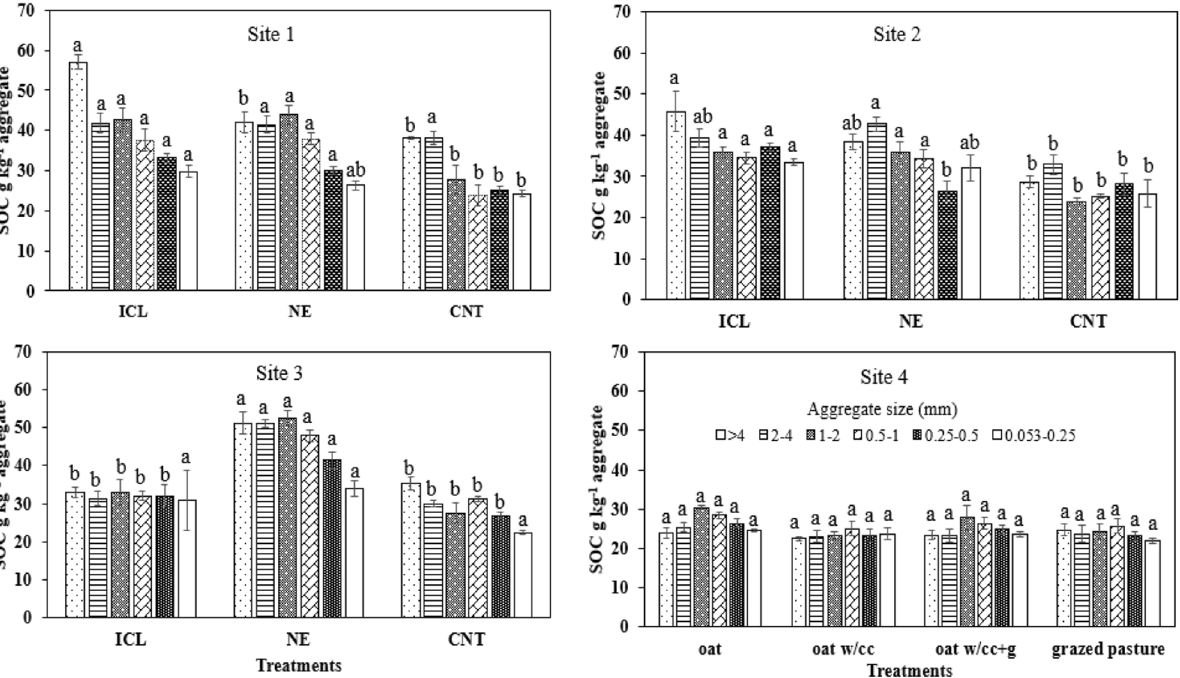
Figure 1. Soil aggregate-associated organic carbon concentration at 0–5 cm depth as influenced by different production systems at sites 1, 2, 3, and 4. Under each site, bars followed by different letters within an aggregate size at different treatments are significantly different at P ≤ 0.05 according to Fisher’s LSD. ICL integrated crop– livestock, NE natural ecosystem, CNT control, CC cover crop, g